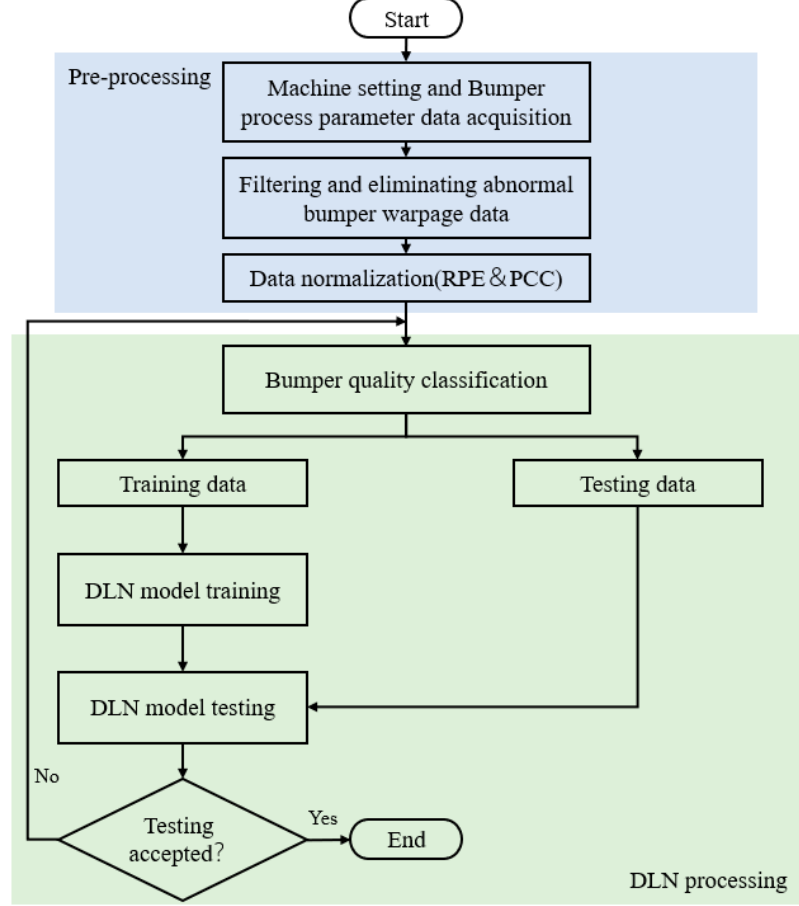
Figure 5. Flow chart of deep learning network modeling operation procedures.